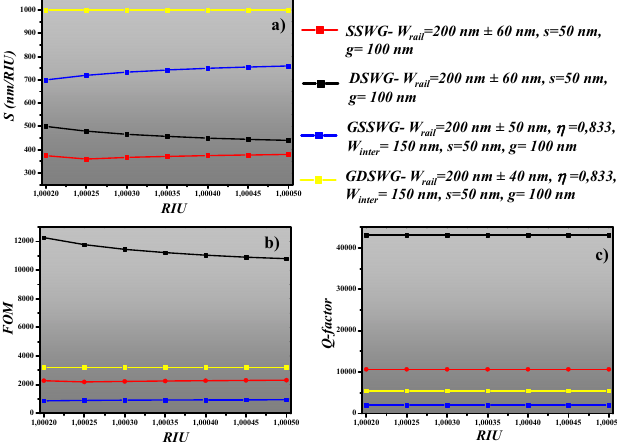
Figure 9. ( a ) Sensitivity, ( b ) FOM , ( c ) Q-factor of all four designs.